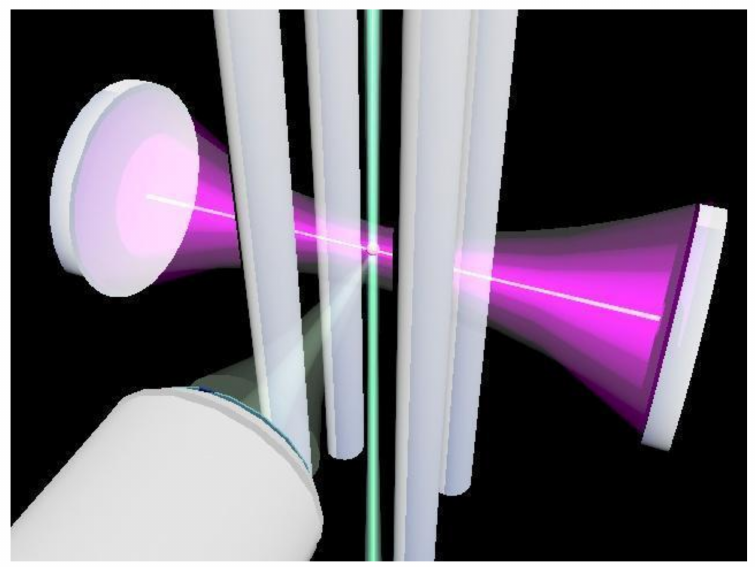
Figure 1. A schematic 3D view of the CRDS standing wave, the ELQ trap setup and the CCD camera